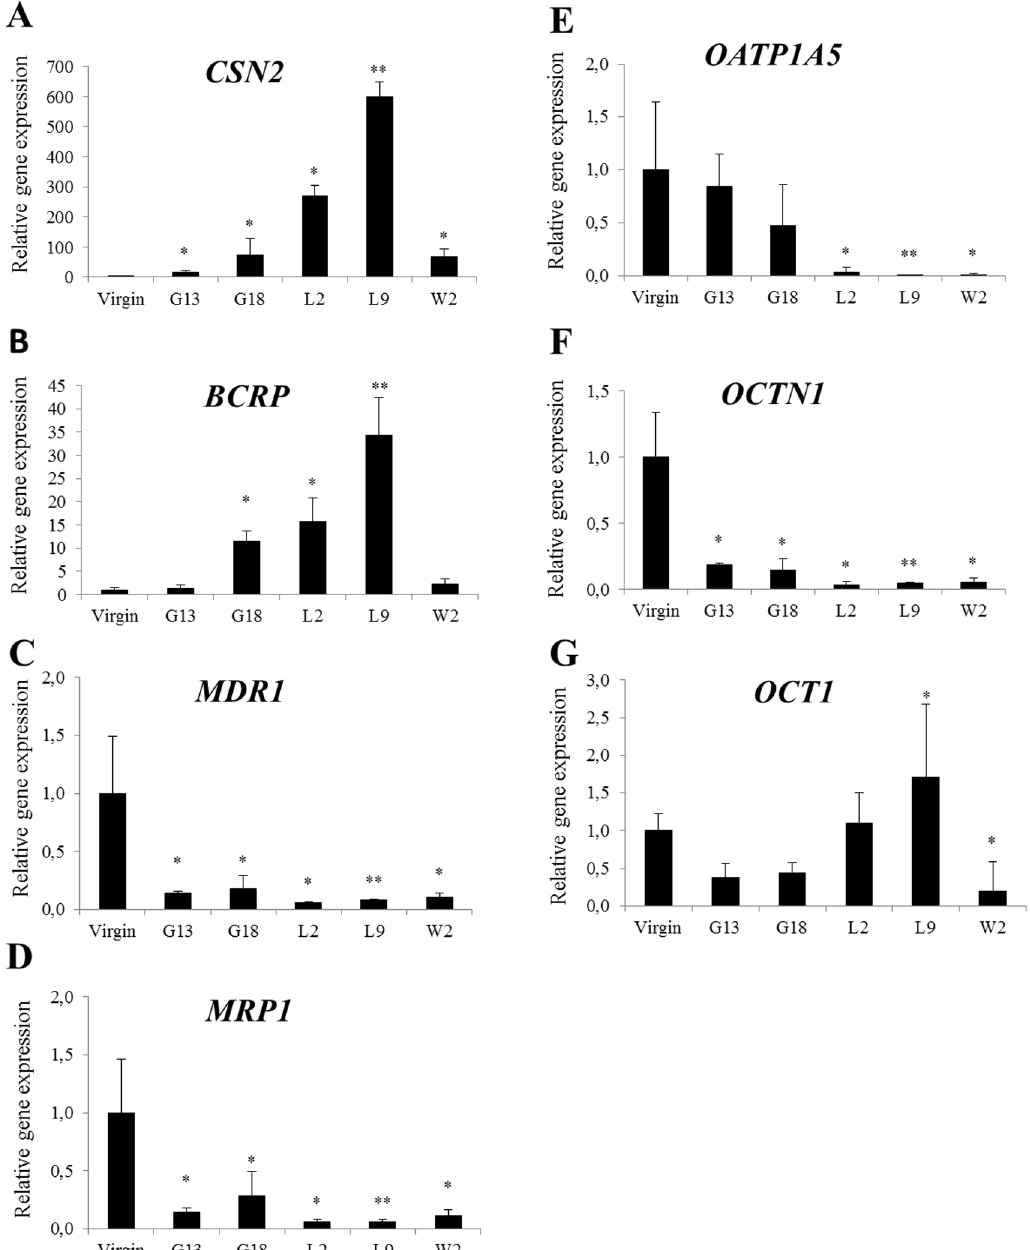
Fig 1. Relative gene expression of CSN2 and transporters (A-G) in the mammary gland of mice. Mammary glands were taken from virgin, pregnant (gestation day 13 and 18), lactating (lactation day 2 and 9) and weaning (weaning day 2) mice. Normalized gene expressions (A-G) are shown relative to virgin and the data is presented as means ± SD; n = 3 – 4. Statistically significant differences as compared to virgins * p (cid:1) 0.05; ** p (cid:1)